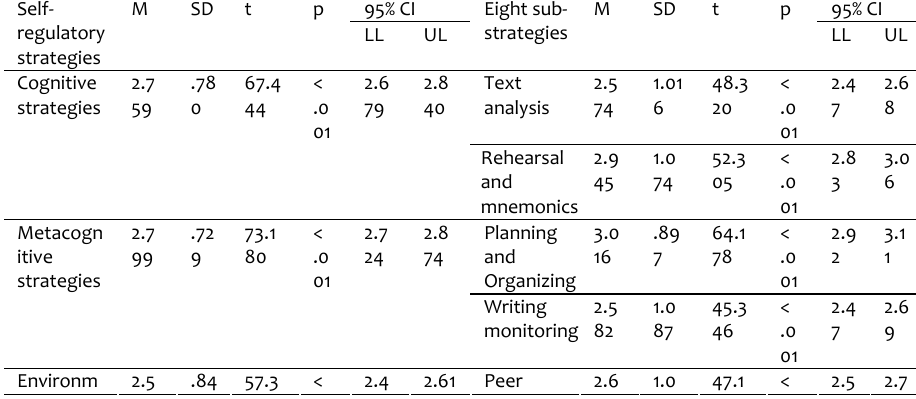
Table 2. Descriptive Statistics and Results of Paired Samples t-tests of SRL Strategies (N =